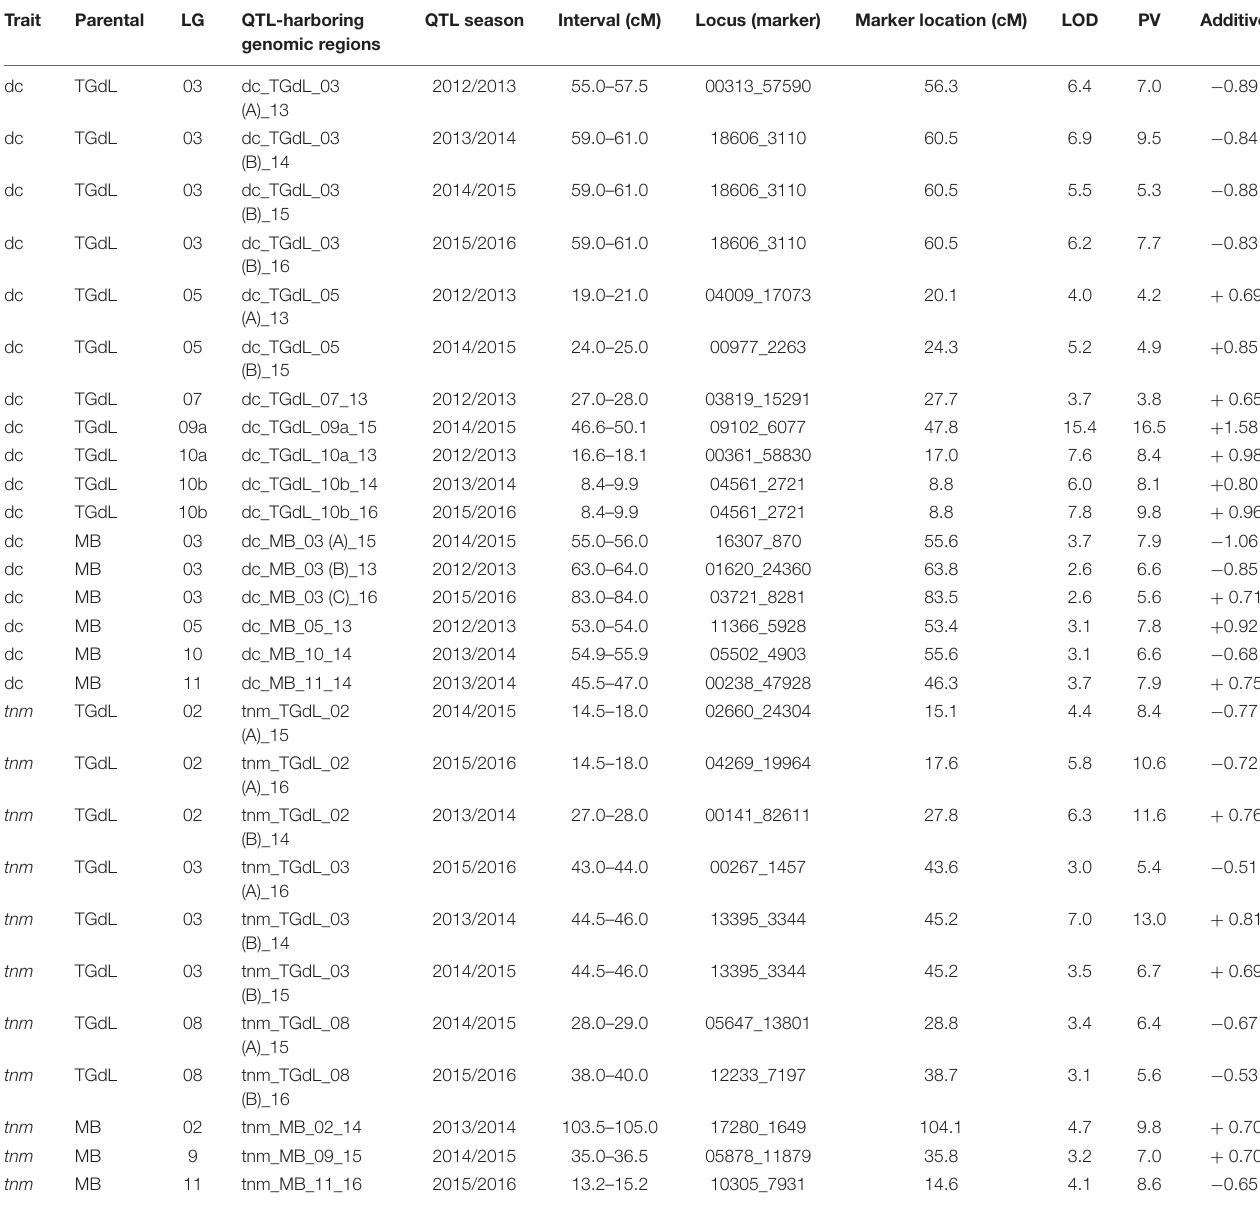
The table records for each QTL, the trait, the map parental where the QTL was detected, Linkage Group (LG), QTL name and season of detection, the interval of the QTL, the closest linked marker (Locus) and its map position in cM, the estimated LOD at the QTL peak (LOD), the PV explained (PV), and the contribution of each parent